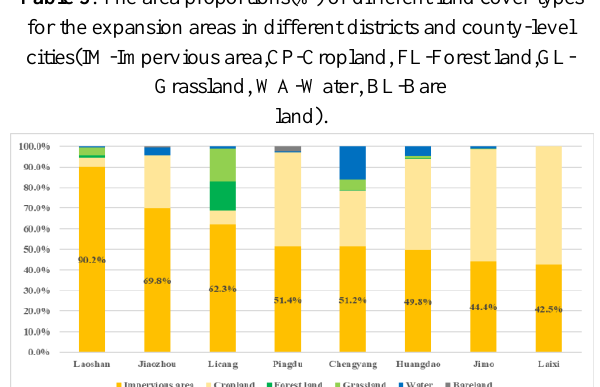
Figure 2 . Annual urban land expansion rates of different districts and county-level cities in Qingdao from 2010 to 2018.